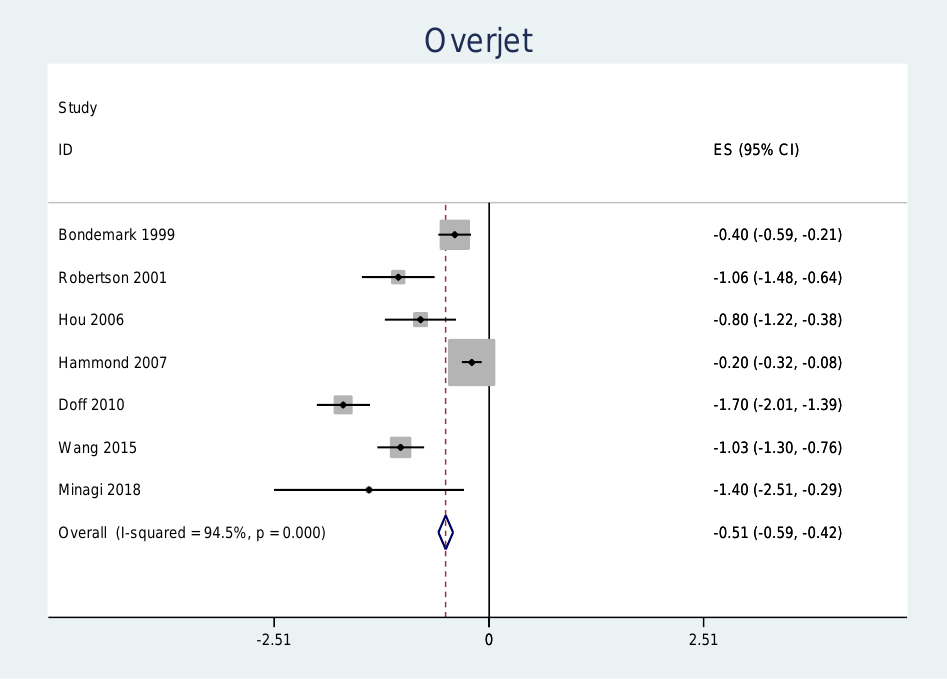
Figure 5. Forest plot of the results of overjet changes using the random-effects model.